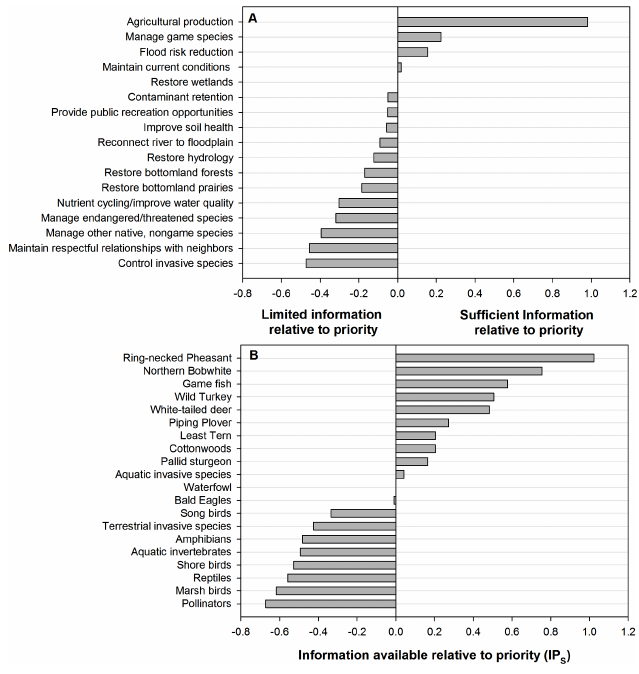
Fig. 4 . Information available relative to priority for (A) management objectives and (B) conservation priority. Values on x-axis were calculated by first standardizing priority and information available scores, then subtracting the standardized priority value from the standardized information available value.